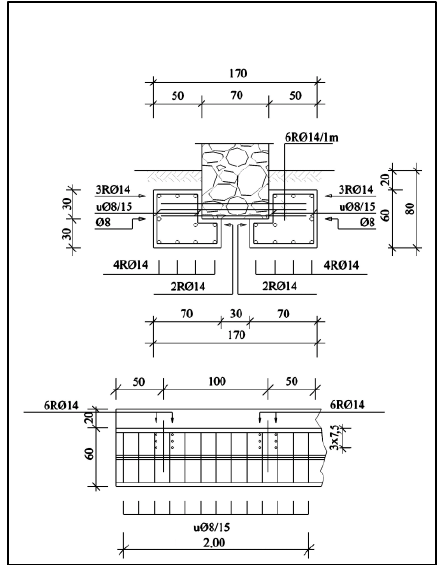
Figure 34. Reinforcement of façade wall foundations. Figure 34. Vertical cross-section of the